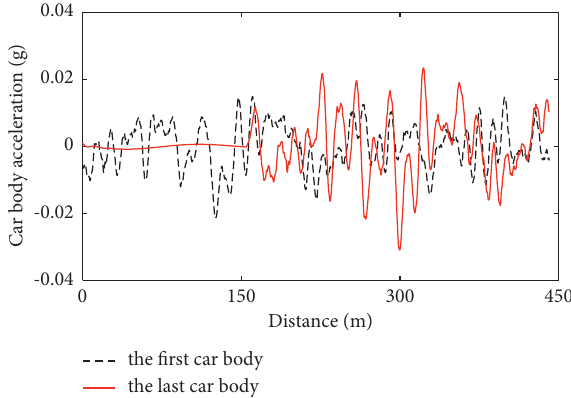
Figure 8: Time histories of the first and last car body accelerations with ( v ) br